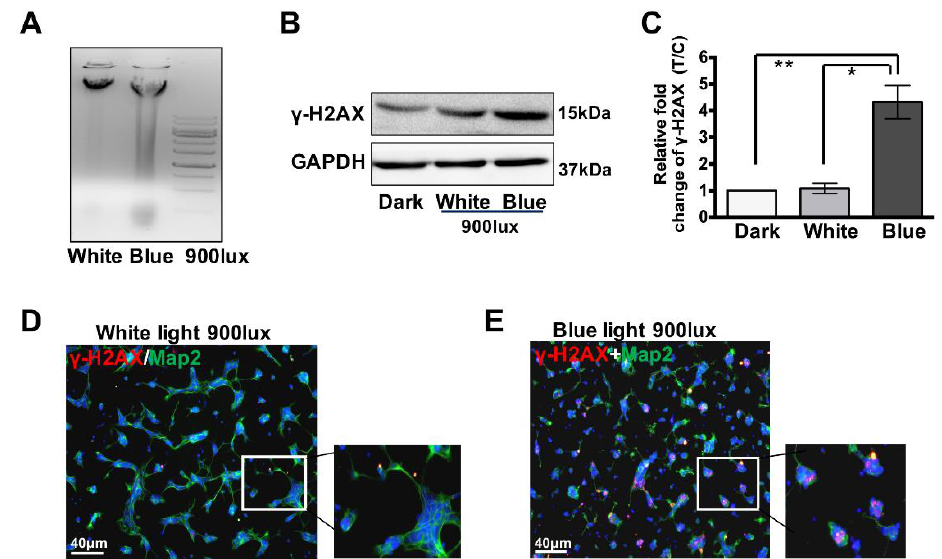
Figure 2. Blue light induces DNA damage in retinal neurocytes. ( A ) A DNA electrophoresis assay shows that severe DNA damage. ( B ) Western blot analysis shows 2 h blue light exposure triggers the up-regulation of γ -H2AX. ( C ) Protein expression was quantified by densitometry, showing the significant up-regulation of target proteins following blue light exposure. ( D ) White light at 1500 lux white light did not induce γ -H2AX foci formation in primary cultured retinal cells. ( E ) Increased γ -H2AX foci forms in retinal neurocytes after blue light exposure. Error bars represent mean ± SD. Asterisks indicate statistically significant differences between control and experimental samples (* p < 0.05, ** p < 0.01).